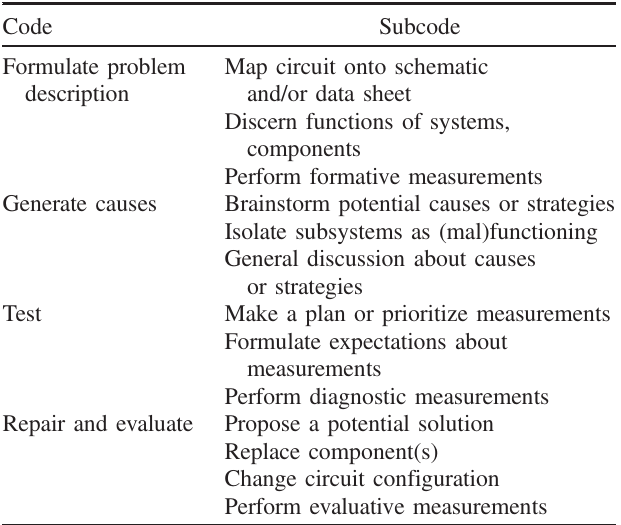
TABLE III. Codes and subcodes for cognitive troubleshooting